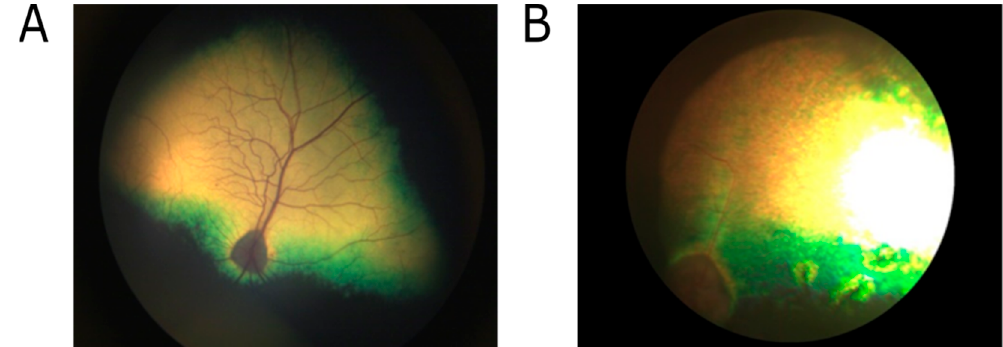
Figure 1. Fundus images captured showing ( A ) unaffected Giant Schnauzer (GS) dam at 11 years; ( B ) progressive retinal atrophies (PRA)-affected GS dog at 5 years of age. Observations of PRA cases include bilateral tapetal hyperrelectivity and retinal vascular attenuation.